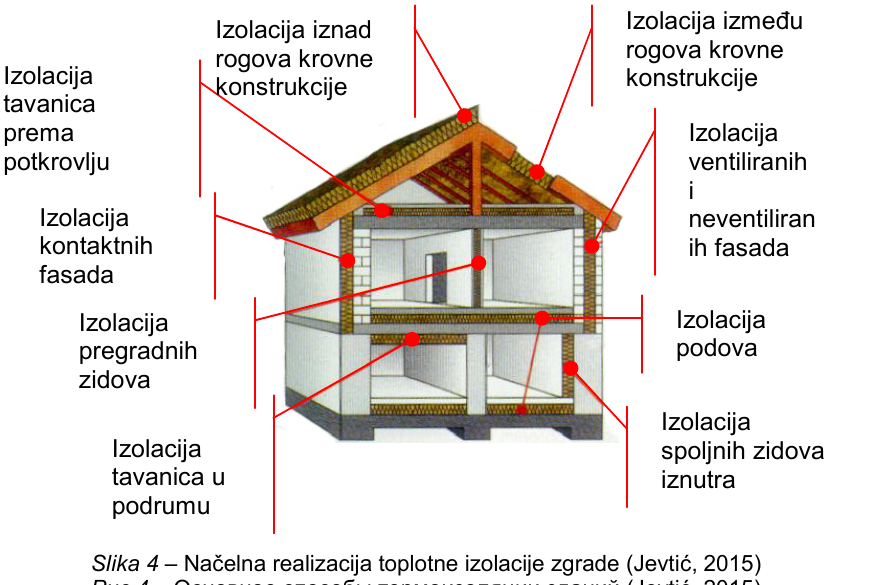
Figure 4 – General realisation of the building thermal insulation (Jevti ć ,